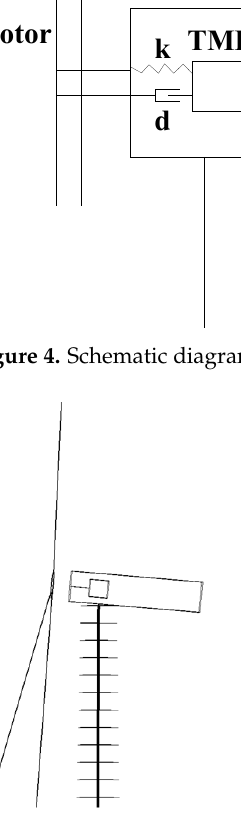
Figure 5. Controlled model of the floating wind turbine with TMD.